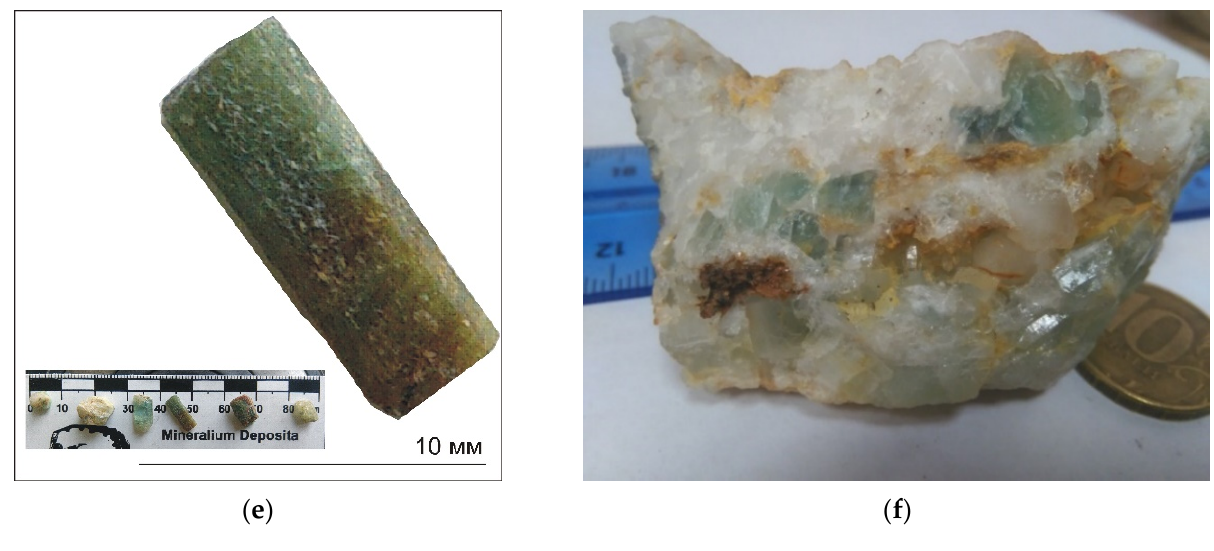
Figure 2. ( a ) Quartz vein crosscut metasediments; ( b , c ) ancient Roman sites for beryl exploration; ( d ) green beryl (emerald) in quartz vein; ( e ) dark-green to brown-green emerald; ( f ) pale-green emerald in quartz.